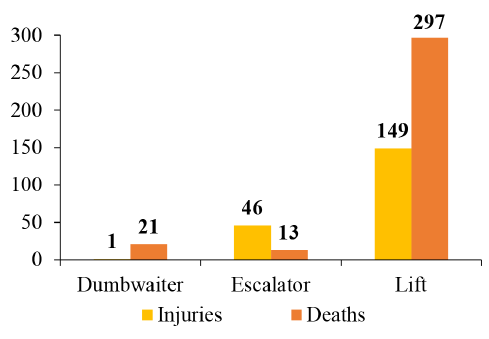
Fig. 3 The casualties of different elevator types in the 412